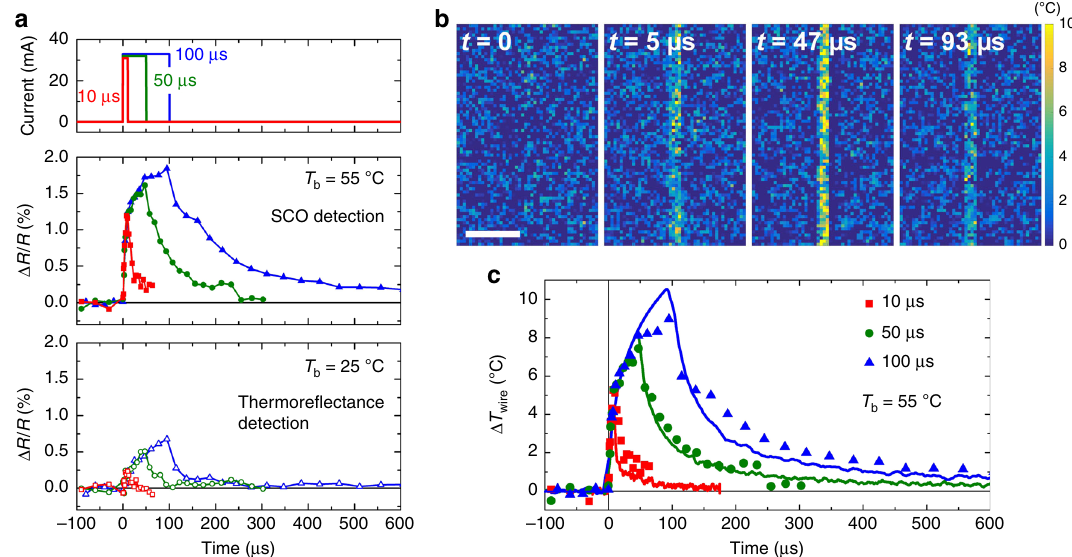
Fig. 6 Temporal resolution and sensitivity. a Time evolution of the optical re fl ectivity ( Δ R / R ) measured on a SCO-coated gold microwire (1 mm × 8 µ m × 300 nm) at two selected base temperatures, T b = 55 °C and T b = 25 °C, following the injection of sharp 10, 50, and 100- µ s-long current pulses (32 mA). At 55 °C (close to the spin-transition temperature) the re fl ectivity change is ampli fi ed by the SCO phenomenon, while the measurements at 25 °C depict the ordinary thermore fl ectance. b Temperature maps ( Δ T ) deduced from the Δ R / R images at T b = 55 °C at selected times, following a 50- µ s-long current pulse. Scale bar, 40 µ m. c Time evolution of the average temperature rise of the wire measured by our SCO-based thermometer. Solid lines correspond to the temperature pro fi les deduced from time-resolved electrical resistance